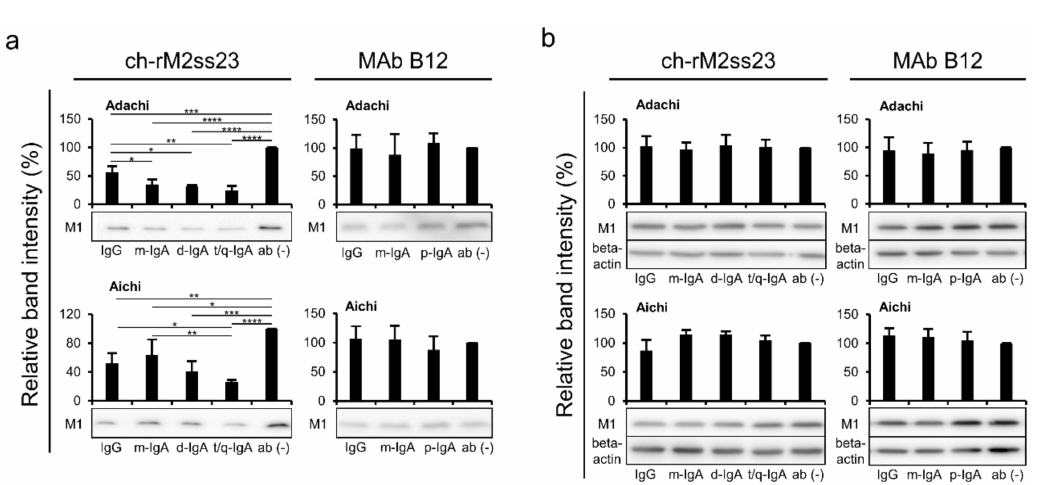
Figure 5. Detection of the viral protein in supernatants and lysates of IAV-infected cells. MDCK cells plated in 12-well plates were infected with IAVs at m.o.i. 2.0 and incubated with or without MAbs B12 and ch-rM2ss23 for 8 h at 35 ◦ C. The cells infected with Adachi and Aichi were incubated with or without the MAbs at 10 µ g / mL and 1 µ g / mL, respectively. The M1 protein in supernatants ( a ) and cell lysates ( b ) was detected in western blotting. Beta-actin was also stained for cell lysate samples. Band intensities relative to each control sample (i.e., cells incubated without MAbs) are shown. Each experiment was performed three times and averages and standard deviations are shown. Asterisks indicate significant di ff erences (* p < 0.05, ** p < 0.01, *** p < 0.001, **** p < 0.0001) found using one-way ANOVA followed by Tukey’s multiple comparison